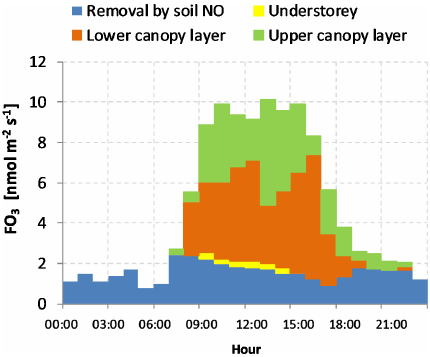
Figure 9. Average diel course of the O 3 removal by the different forest layers and by the NO emitted from the forest